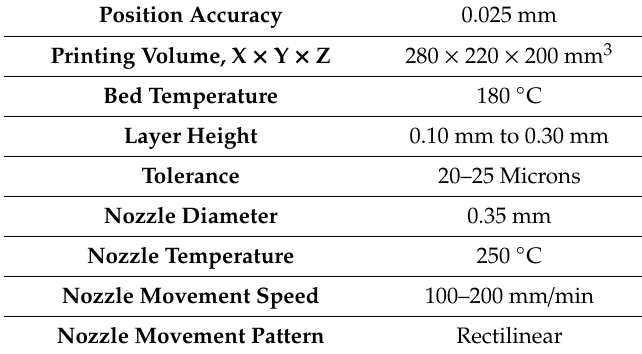
Figure 4. ( a ) Standard test specimen on ARGO machine bed: (b) 3D printed CPEEK specimens. Table 3. Specifications of the fused filament fabrication (FFF) process machine.